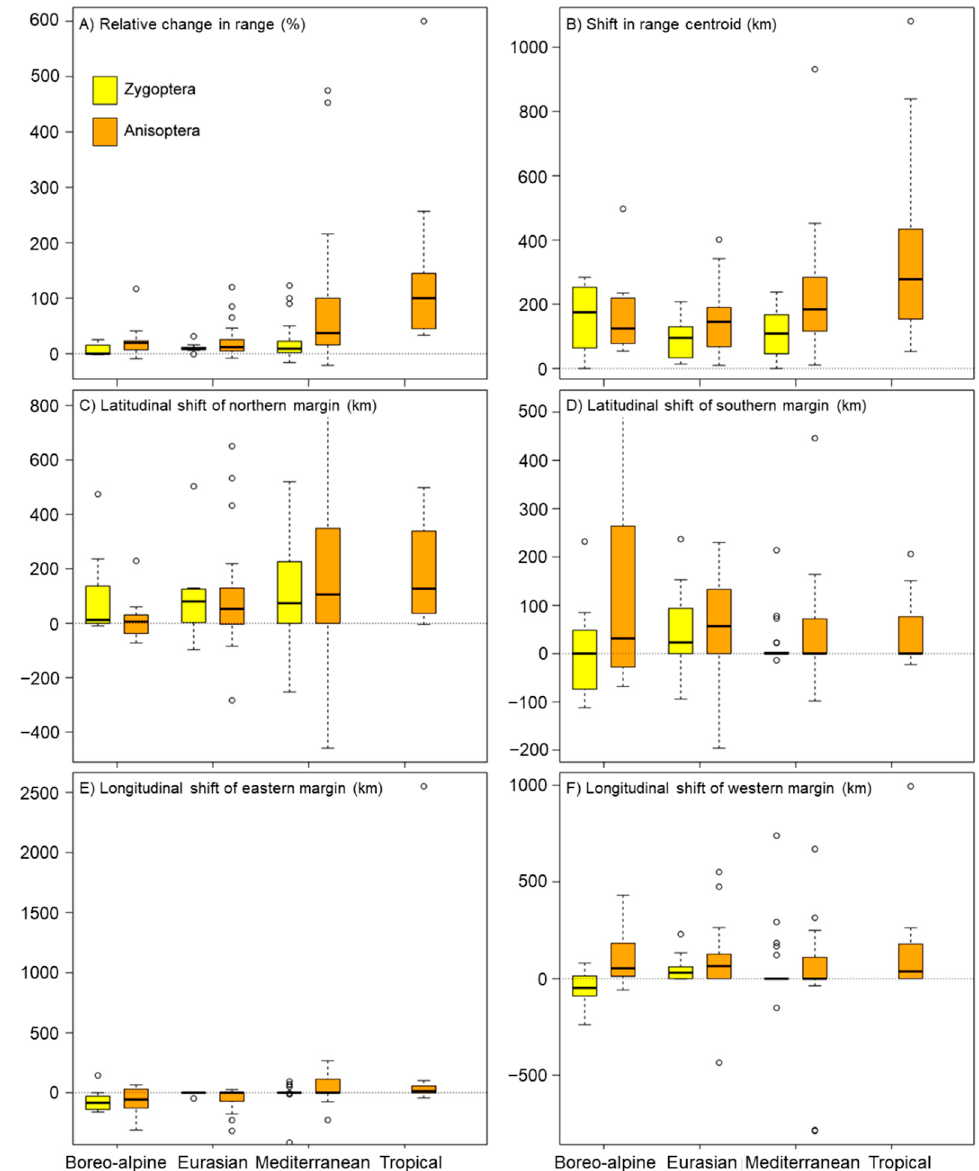
Figure 1. Range shifts in European dragonfly (Odonata) species from 1988 to 2010. ( A ) Relative change in range (percent change in number of occupied 100 × 100 km grid cells). ( B ) Distance shift of range centroid. ( C ) Latitudinal shift of northern range margin. ( D ) Latitudinal shift of southern range margin. ( E ) Longitudinal shift of eastern range margin. ( F ) Longitudinal shift of western range margin. Data separated by biogeographical groups (Tropical, Mediterranean, Eurasian, and Boreo-alpine) for damselflies (Zygoptera, yellow) and true dragonflies (Anisoptera, orange). The box-and-whisker plots illustrate the spread and skewness of the data through their quartiles and the median (thick black middle line). The whiskers extending from the box show data variability outside the upper and lower quartiles. Outlier points that differed significantly from the rest of the dataset are plotted as individual points (empty circles) beyond the